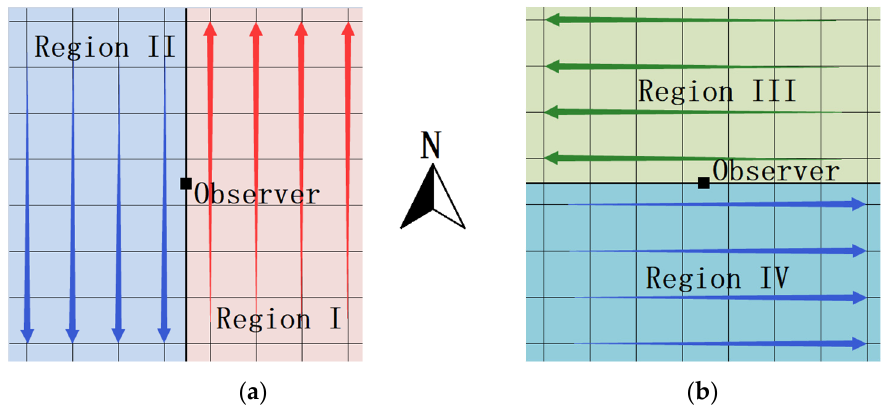
Figure 1. All target points are divided into four overlapping regions. Points are processed line by line, and lines closer to the ovserver are processed before the ones farther to the observer: ( a ) Region I and Region II; ( b ) Region III and Region IV. I and Region II; ( b ) Region III and Region